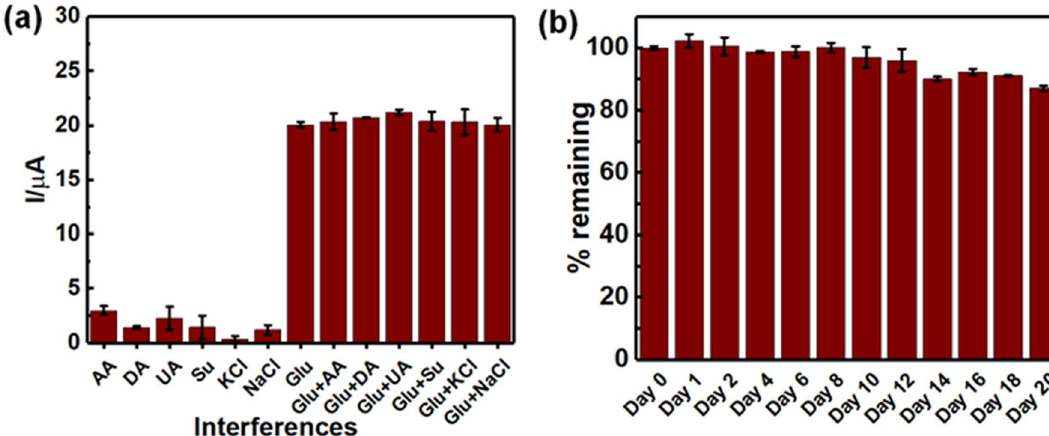
Figure 5. Anti-interference study and stability test. ( a ) Interference study of glucose sensor; the responses of 0.10 mM AA, DA, UA, Su, KCl, and NaCl in the presence and absence of 1.0 mM glucose at the fabricated glucose sensor, applied working potential of + 0.50 V and ( b ) stability test of Cu(II)/rGO based glucose sensor; current responses of 2.5 mM glucose